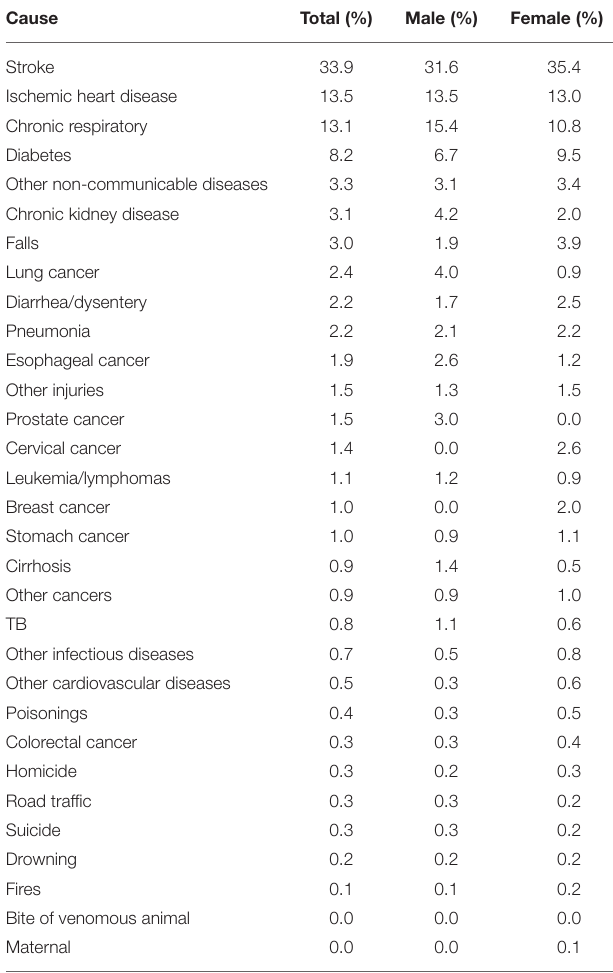
TABLE 1 | Age distribution of deaths for the VA sample and for out-of-hospital deaths in corresponding areas recorded in the RG data (2014) and estimated by the GBD (2017).